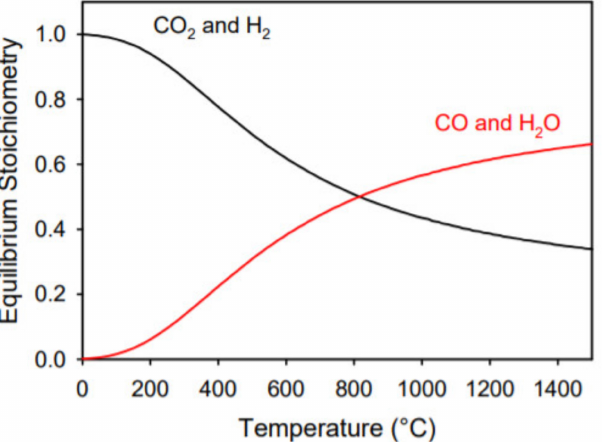
Figure 2. Thermodynamic equilibrium composition as function of temperature for the WGS reaction (Reprinted with permission from [25]. 2007,